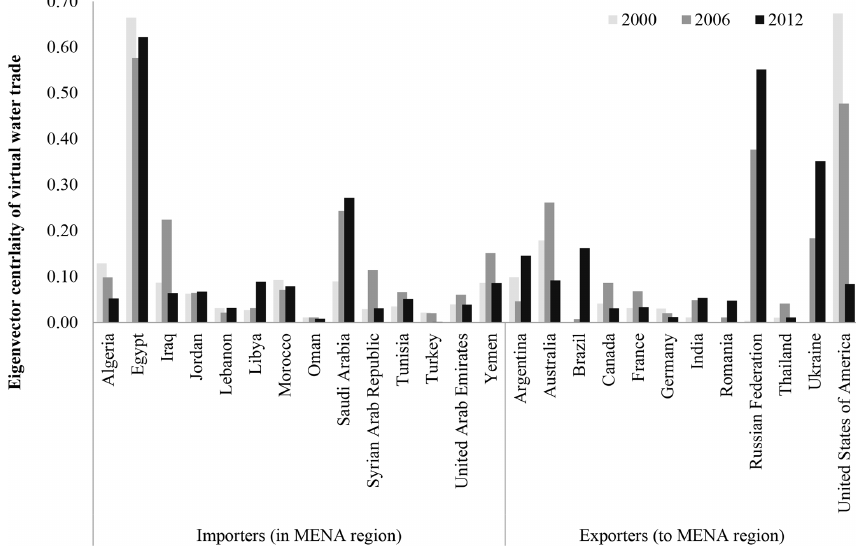
Figure 7. Eigenvector centralities of the virtual water trade network in the MENA region in 2000, 2006, and